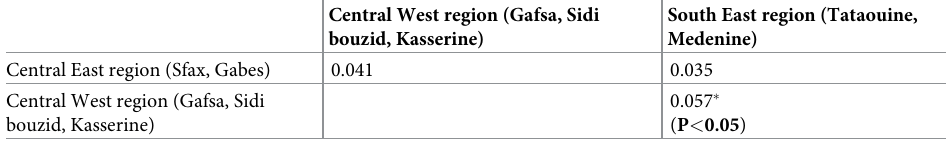
Table 4. Genetic differentiation ( F st index) between M . bovis populations of the different